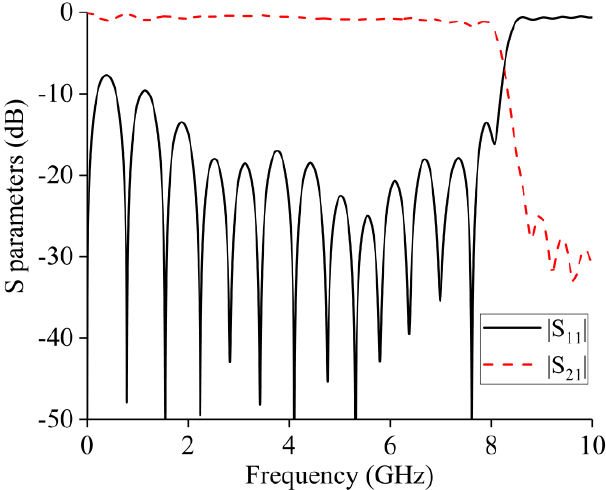
Figure 3. Simulated lowpass response of the double-layered spoof surface plasmon polariton waveguide.